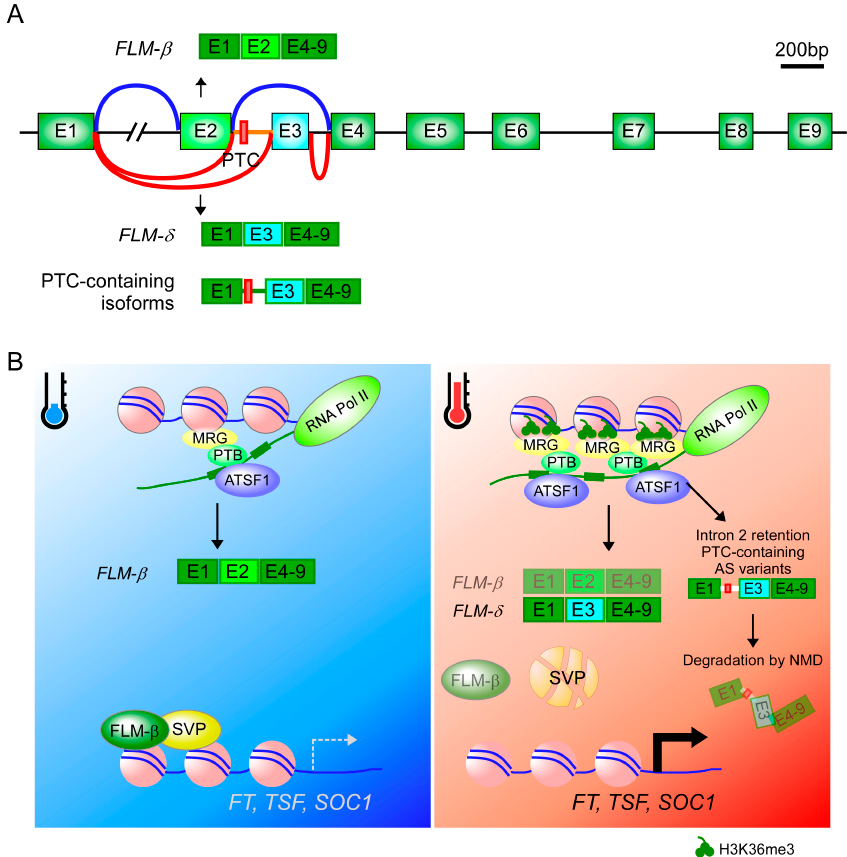
Figure 2. Possible regulation of alternative splicing of FLM at different ambient temperatures. ( A ) Schematic representation of the exon/intron structure of the FLM locus and possible alternative splicing at high ambient temperature (red lines) and low ambient temperature (blue lines). At low ambient temperature, the FLM- β transcript, which contains exon 2 (E2), is the predominant splicing variant, but at high-ambient temperature the FLM- δ transcript and premature termination codon (PTC)-containing isoforms are the predominant splicing variants. ( B ) H3K36me3 levels in the FLM locus are low at low ambient temperature (blue thermometer) allowing the robust production of FLM- β , the repressive form, to repress the expression of FT , TSF , and SOC1 together with SVP protein. At warm temperature (red thermometer), the elevation of H3K36me3 levels at the FLM locus enhanced the production of other splicing variants such as the FLM- δ transcript and PTC-containing isoforms, which reduces the amount of FLM- β , probably through the tethering mechanism of splicing factor (SF1) and the Polypyrimidine Tract Binding Protein (PTB) to MRG, a histone reader. The PTC-containing isoforms are non-functional and degraded by nonsense-mediated mRNA decay (NMD). The lower level of FLM- β together with the degradation of SVP protein, which results in low abundant FLM- β -SVP repressor complex and thus release the repression of FT transcription. Faint oval and fragmented ovals indicate proteins with low abundance and degraded protein, respectively. Arrows and dashed arrows denote activation and inability to activate, respectively.